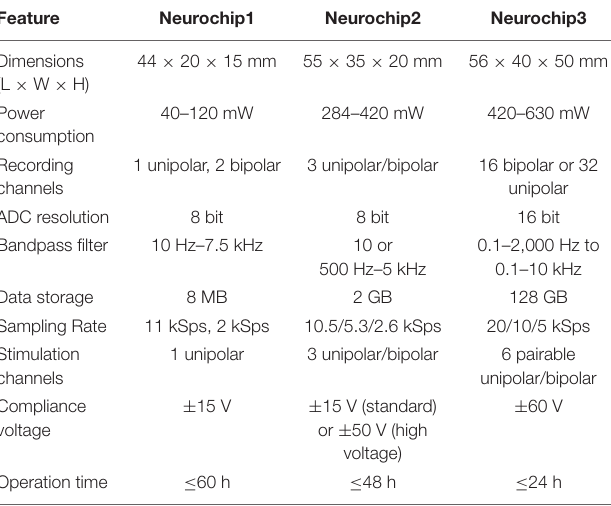
TABLE 1 | Comparison of Neurochips 1, 2, and 3.